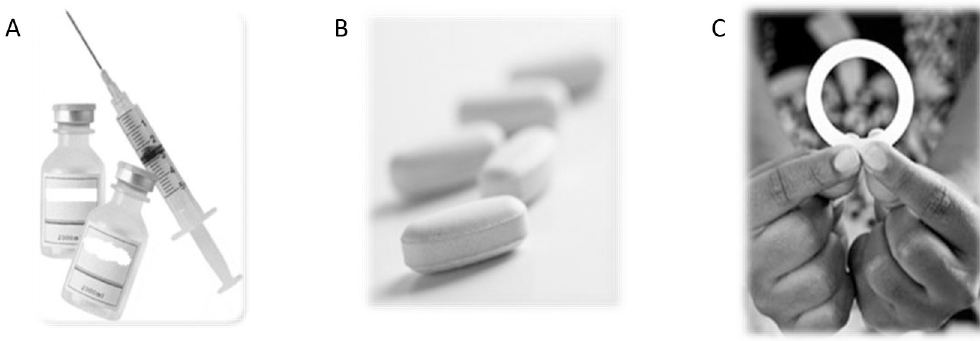
Fig 1. Product images. The TRIO study used three placebo delivery forms of potential Multipurpose Prevention Technology products for future prevention of pregnancy and HIV: (A) injections, (B) oral tablets, and a (C) vaginal ring.